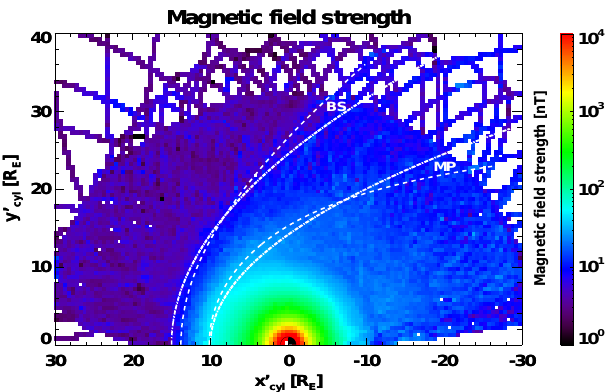
Fig. 1. Spatial distribution of the magnetic field strength (colour- coded) in Earth’s plasma environment measured by THEMIS dur- ing the period March 2007 to February 2010. Data are binned and presented in cylindrical coordinates. The dashed and dashed-dotted lines represent bow shock (BS) and magnetopause (MP) models de- rived from spacecraft measurements and a theoretical